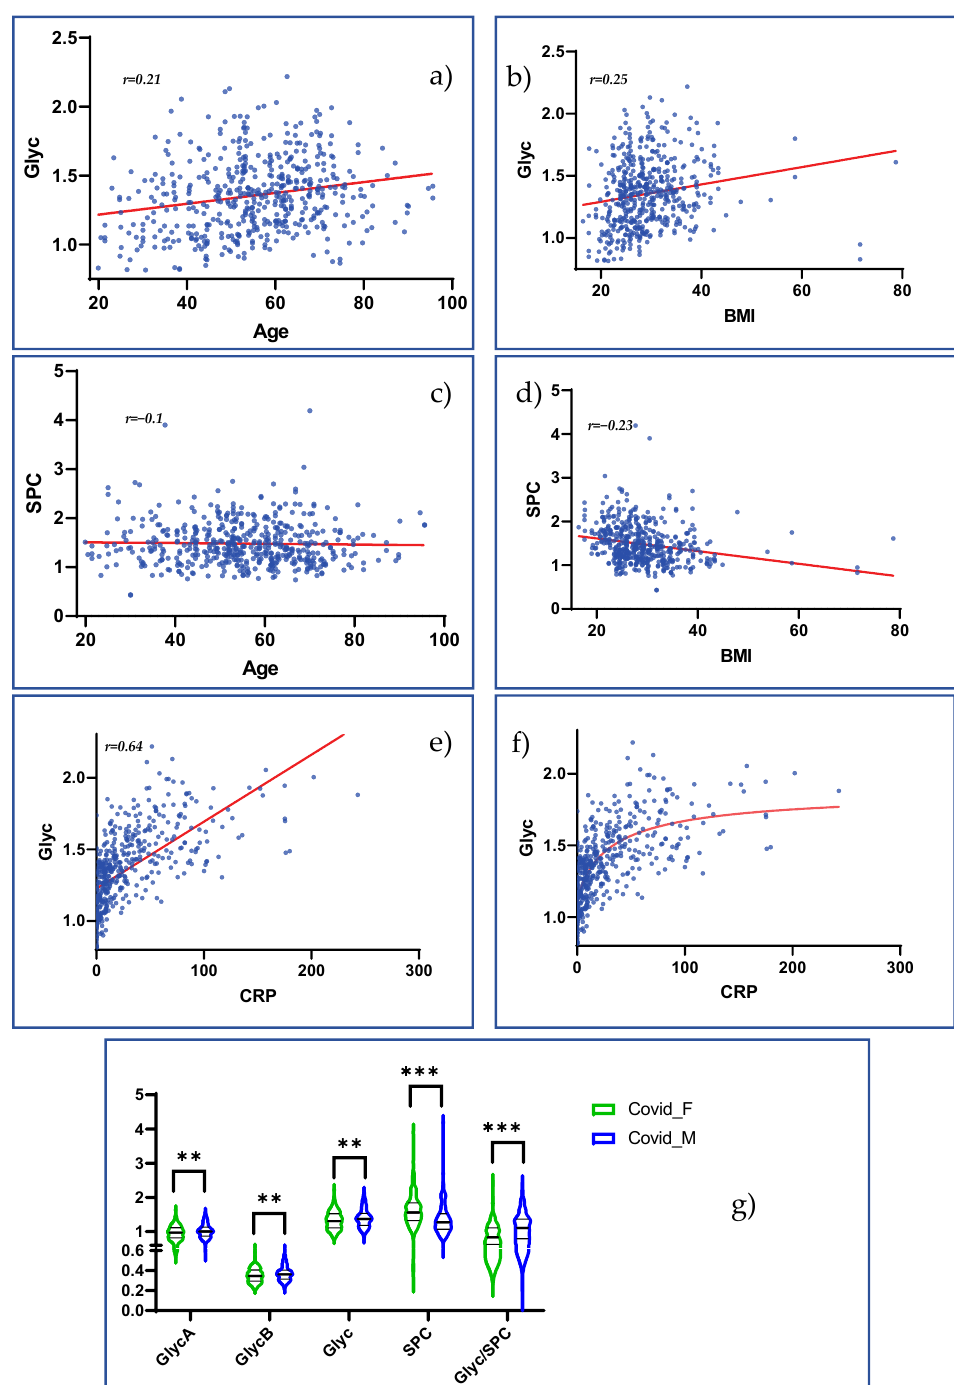
Figure 8. Relationship of 1H-NMR inflammation markers Glyc (sum of glycoprotein A and B) and SPC with possible confounders of age ( a , c ) and BMI ( b , d ). In subfigures ( e , f ), we examined the correlation of Glyc with CRP. The red line, which represents the trend line in subfigures ( a – f ), represents a linear correlation in subfigure ( e ) and a nonlinear correlation in subfigure ( f ). Correlation coefficients (Pearson) are given in the upper left corner of the subfigures with an analysis of linear correlation. ( g ) A possible correlation also exists between Glyc and SPC with the respective sex. Asterisks describe the significance level of a sex-specific distinction (** = p ≤ 0.01, **** = p ≤